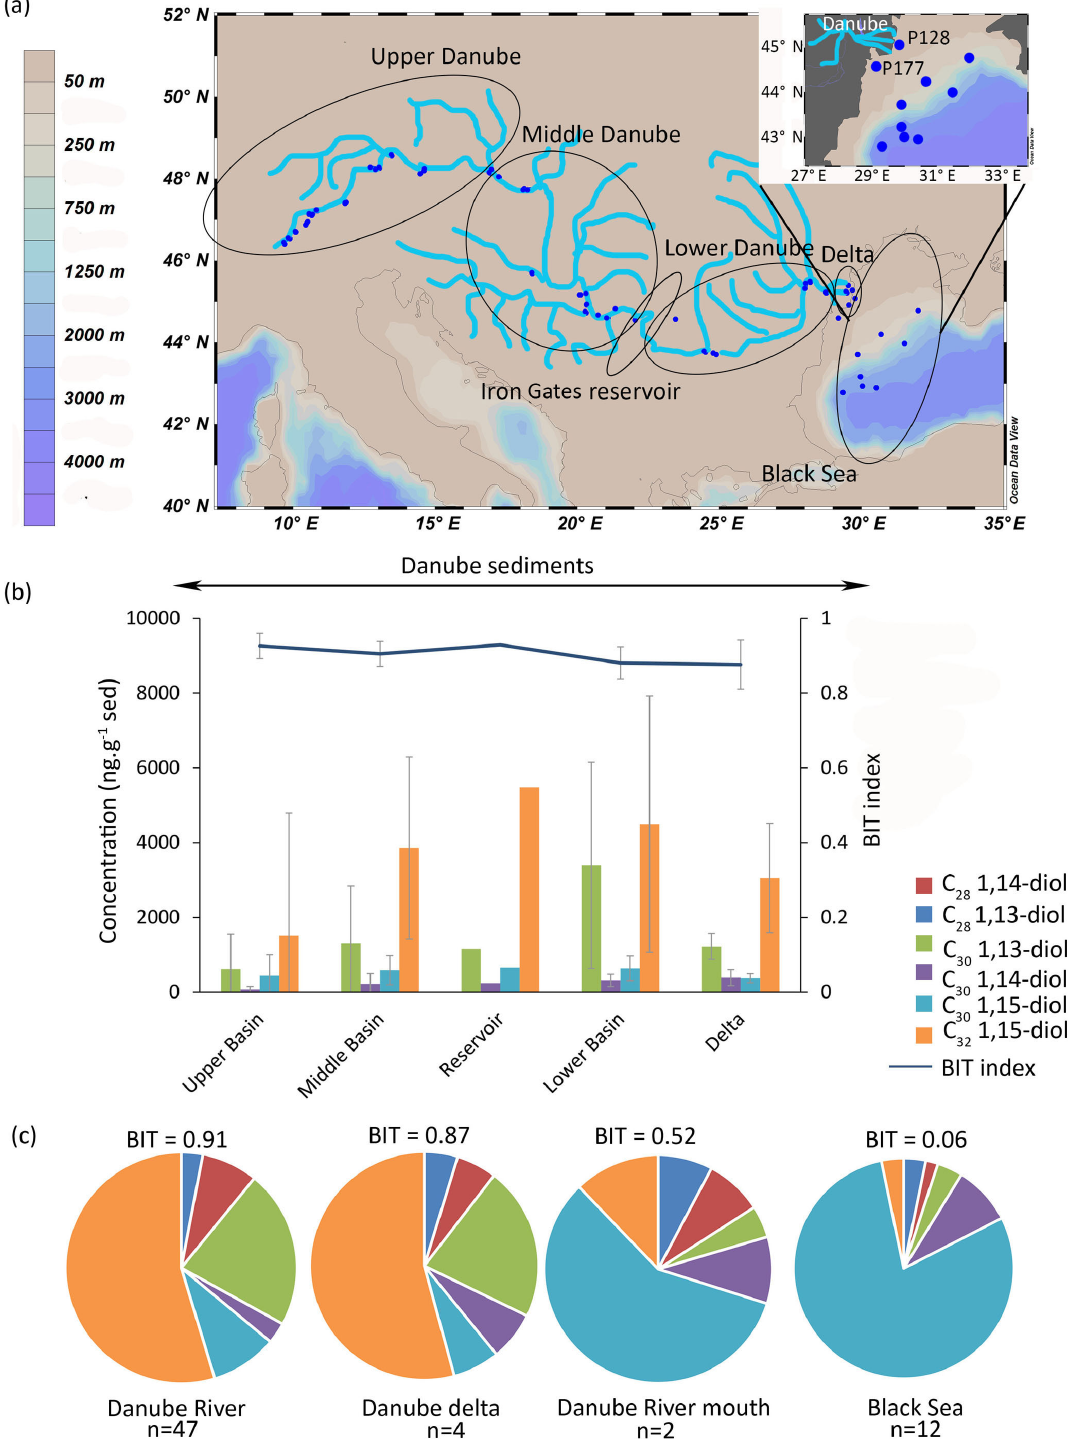
Figure 2. (a) Location of the Danube samples with enhanced view of the Danube River mouth samples, (b) concentration of LCDs (this study) and BIT values (from Freymond et al., 2017) in the Danube sediments ( n = 1 for the reservoir), and (c) fractional abundance of the LCDs in the Danube (average of the upper, middle, and lower Danube), Danube delta, Danube River mouth (stations P128 and P177), and Black Sea (12 stations). Grey bars indicate the standard deviation for each